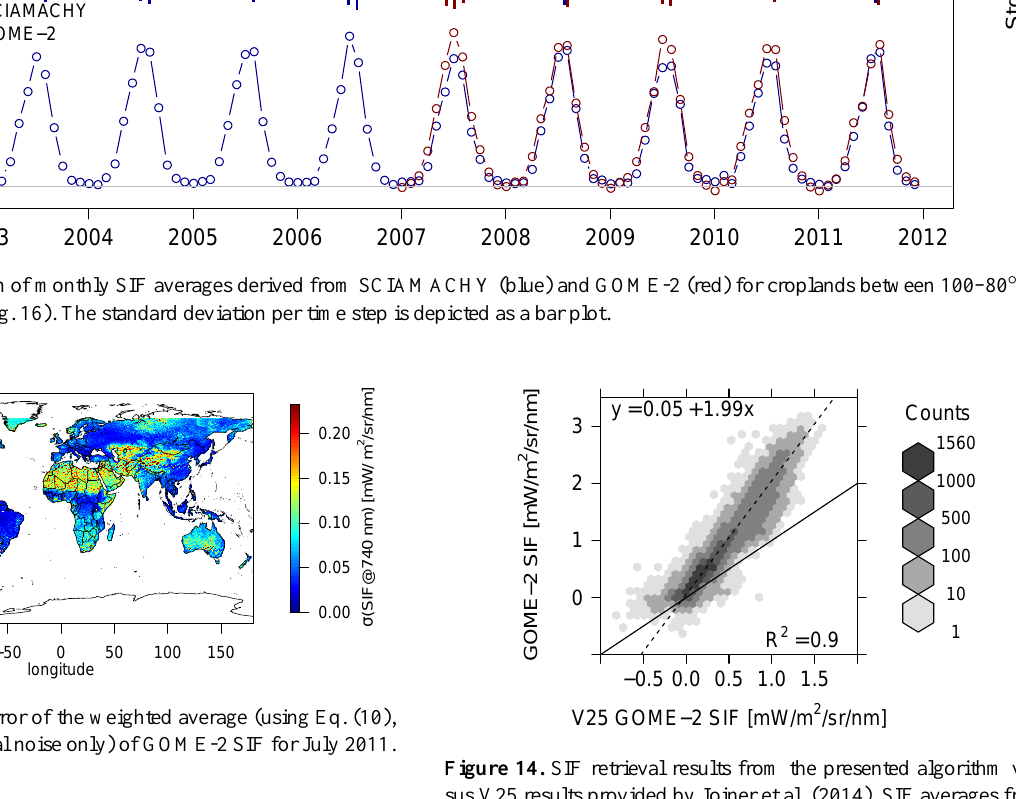
picted in Fig. 14 for the overlapping period in time (Febru- ary 2007 to December